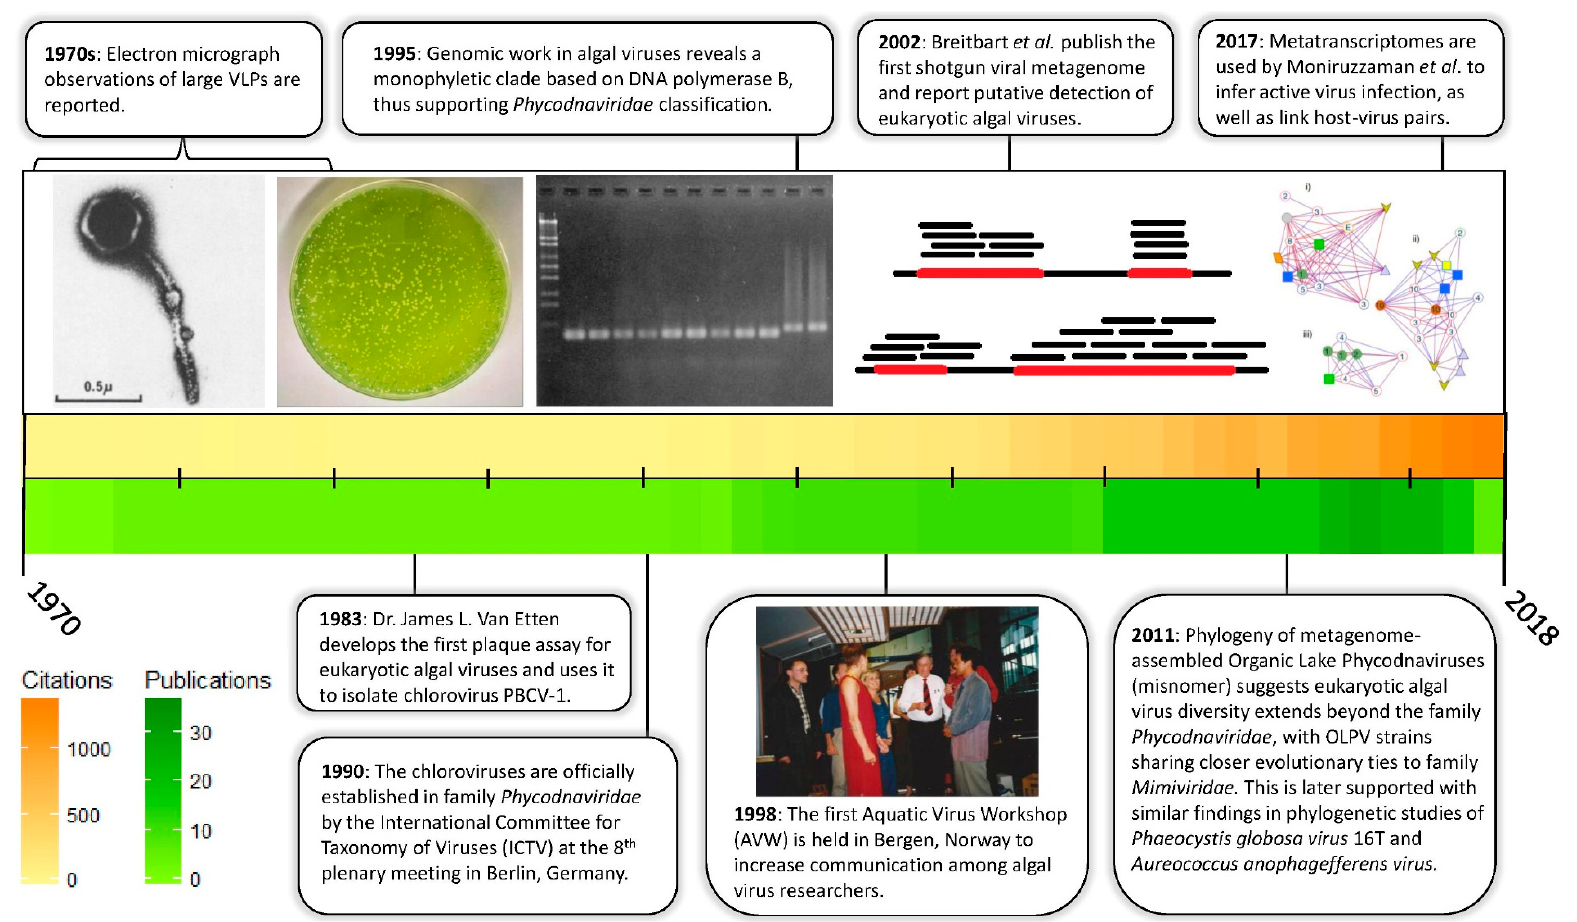
Figure 1. Timeline of eukaryotic algal virus research with important milestones highlighted. Colored bars represent the annual citations and publications generated from a Web of Science Citation Report using the field tag TS = (algal virus) for all databases. The search was conducted on 8 May 2018 at 11:00 a.m. Citation Report results were visualized as heatmaps using custom R scripts. Electron micrograph image [10] and electrophoretic gel [11] reprinted by permission. Network analysis [12] reprinted under authority of Creative Commons.